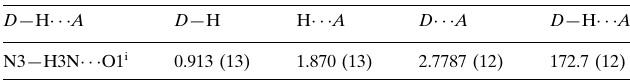
Hydrogen-bond geometry (A˚ , (cid:1)